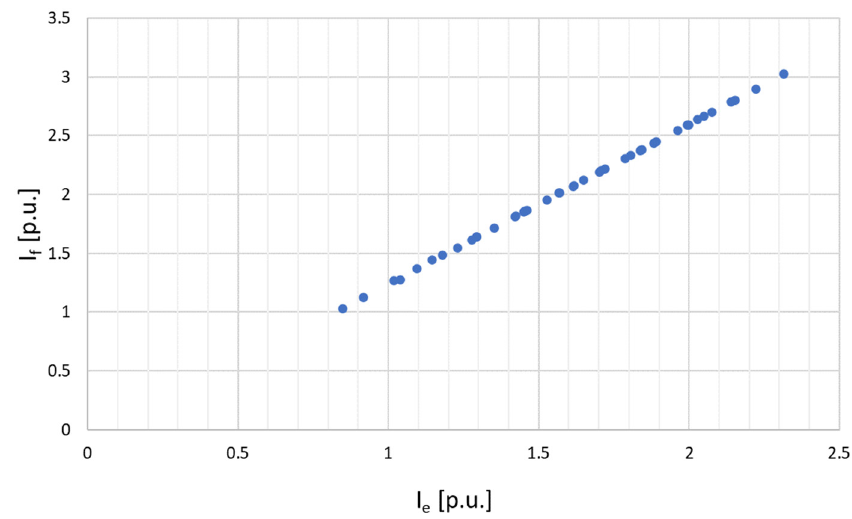
Figure 9. Relationship between I e (DC) and I f (DC) for the simulation model exciter.